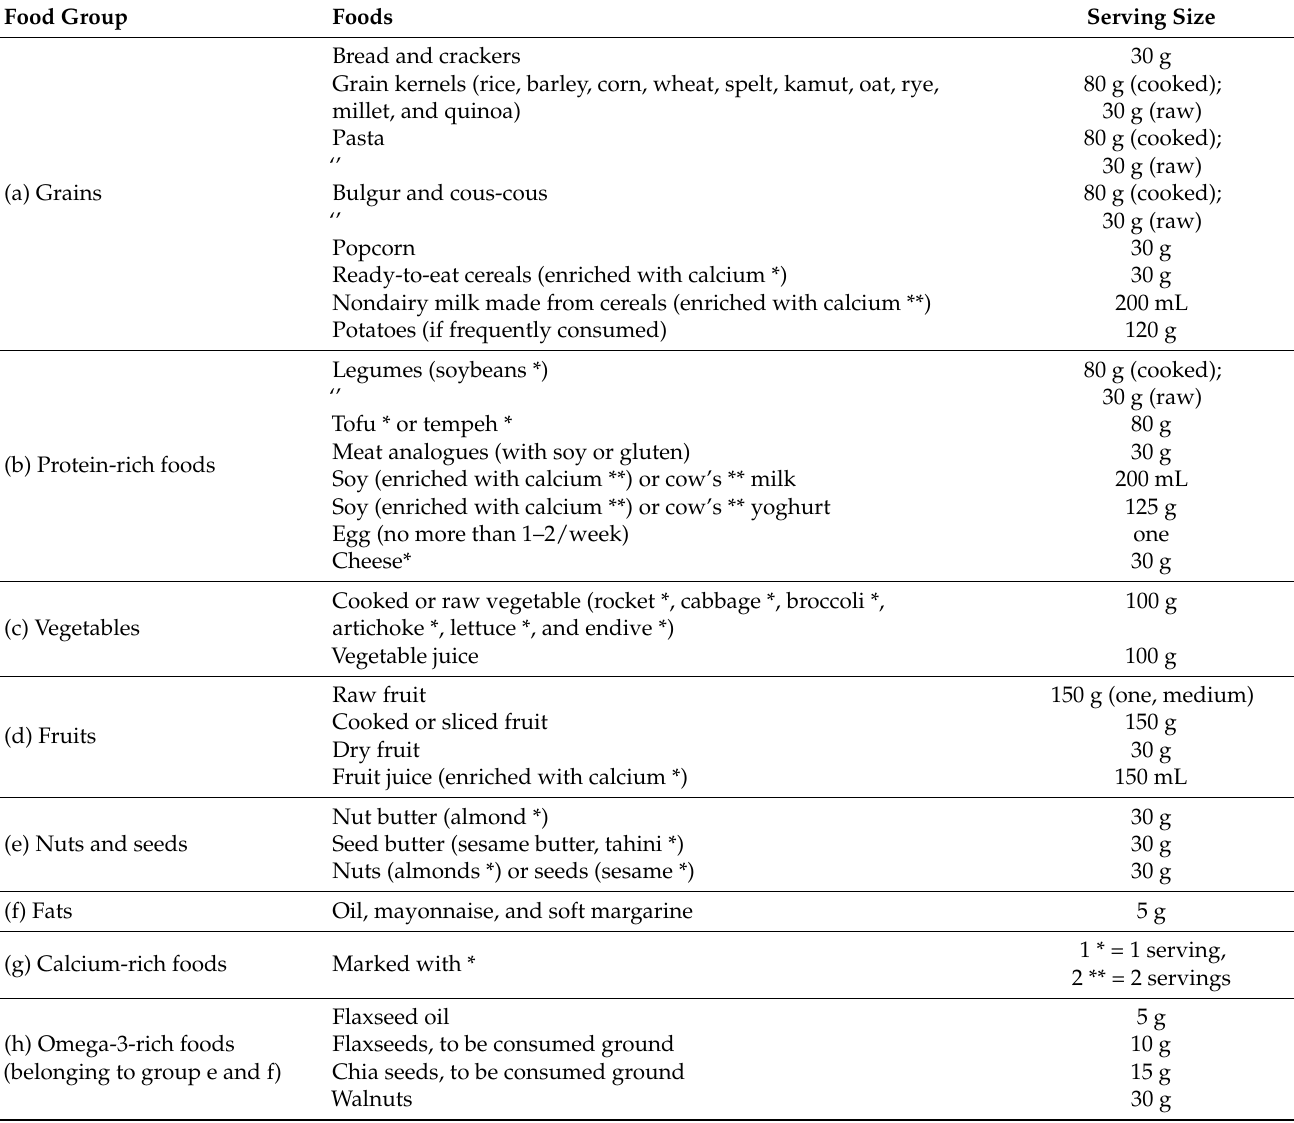
Table 1. Serving sizes specific for each food group of the VegPlate for Sports (* = calcium-rich foods). Food Group Foods